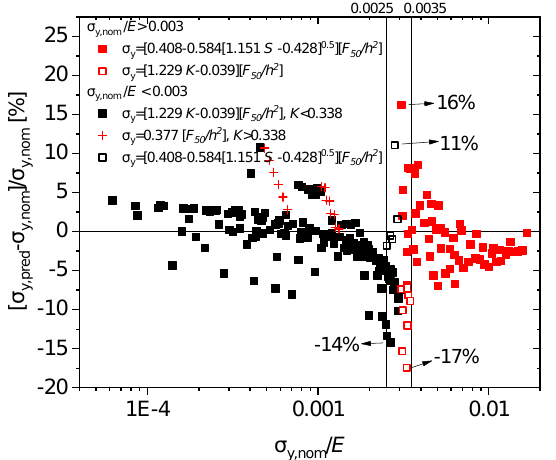
Figure 8. Predictive performance of the curvature- and slope-based formulas in the transition